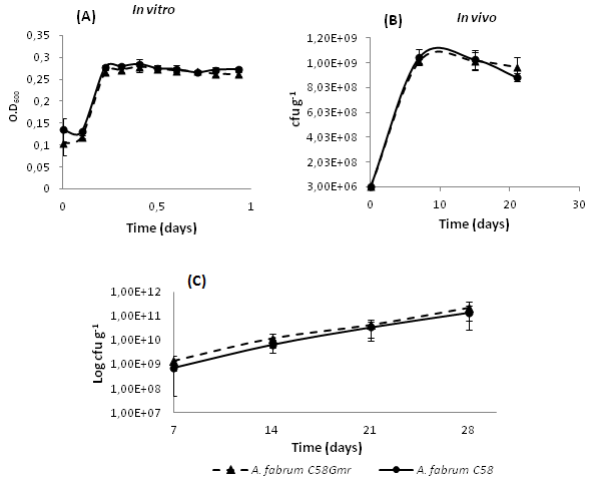
Figure 5. Growth curves (mean optical density measures) of A. fabrum C58 and its mutant: (A) in vitro (YPG medium) during 20 h; (B) in vivo (soil) during 21 d; and (C) in the rhizo - spheres of co-inoculated roots of seedling tomato plants.